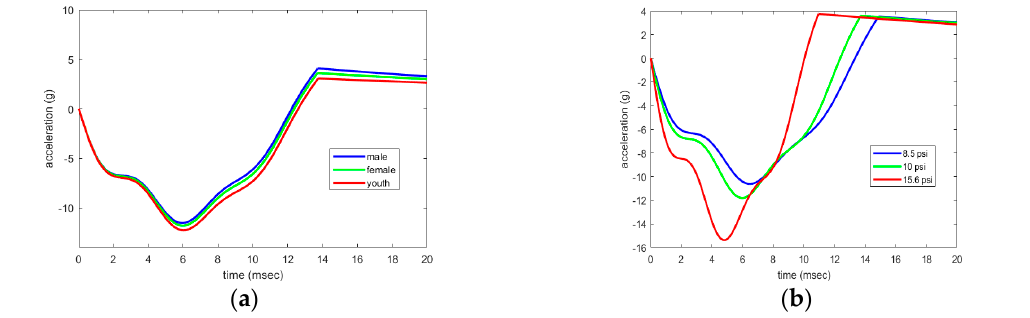
Figure 3. The effect of a ball pumped to 10 psi ( a ) on the displacement of the head of men, women, and youth and the effects of different ball pressures ( b ) within the FIFA range on the acceleration n of the head in youth. Peak accelerations for the 8.5 psi, 10 psi, and 15.6 psi are 11.12 g, 12.31 g, and 15.92 g respectively.